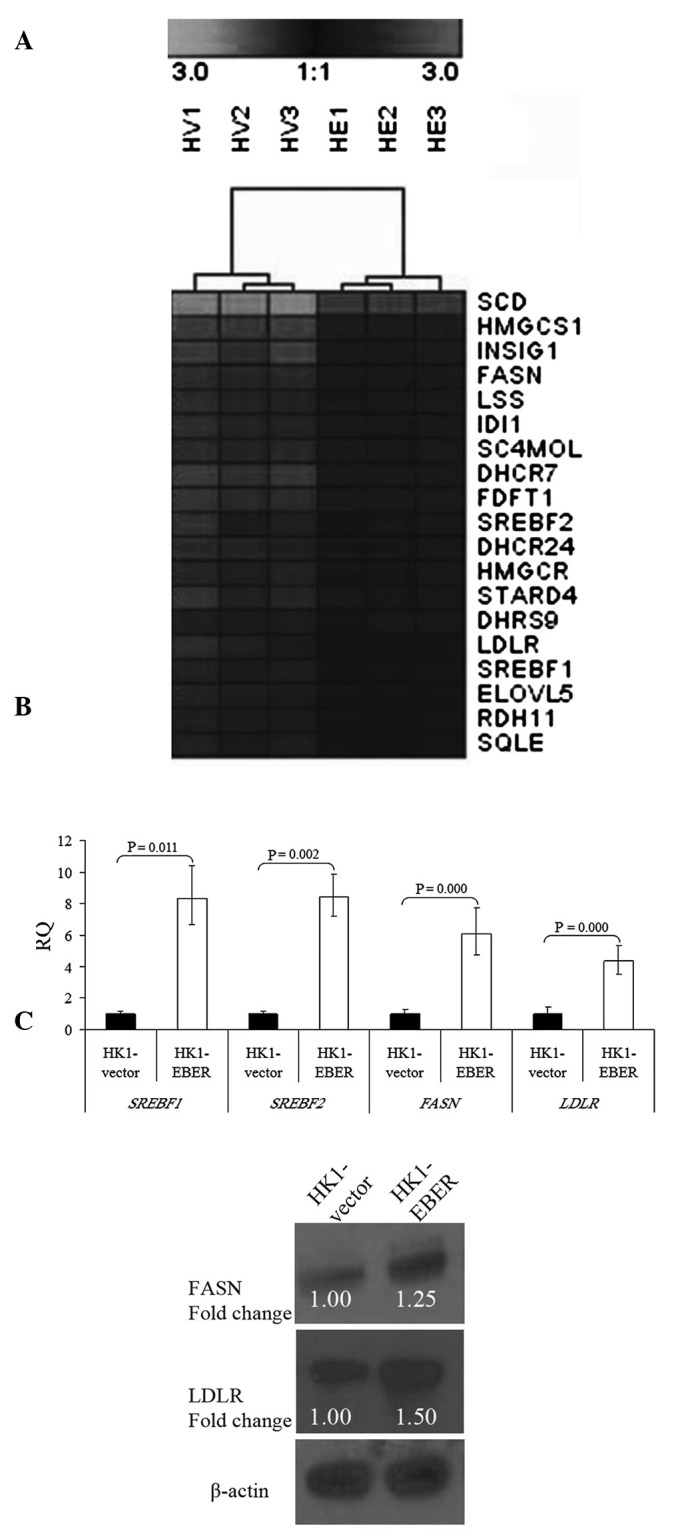
Hierarchical clustering of transcripts and validation of gene expression. (A) Selected gene expression clusters of functionally annotated gene sets representing the cellular lipid metabolic process. Varying shades represent downregulation and upregulation (P<0.05). HV, HK1-vector; HE, HK1-EBER. (B) qRT-PCR of SREBF1 and 2, FASN and LDLR in HK1-EBER and HK1-vector. mRNA levels of SREBF1 and 2, FASN and LDLR were found to be significantly increased in HK1-EBER (P<0.05). ACTB and PPIA were used as multiple controls for normalization. Relative expression levels were calculated by 2-ΔΔCt and reported as RQ. (C) Overexpression of FASN and LDLR in HK1-EBER demonstrated by western blot analysis. ACTB was used as the loading control. Similar results were obtained in two subsequent independent experiments. EBERs, Epstein-Barr virus-encoded RNAs; qRT-PCR, quantitative reverse transcription polymerase chain reaction; SREBF, sterol regulatory element binding protein; FASN, fatty acid synthase; LDLR, low-density lipoprotein receptor; ACTB, β-actin; PPIA, peptidylprolyl isomerise A; RQ, relative quantification.